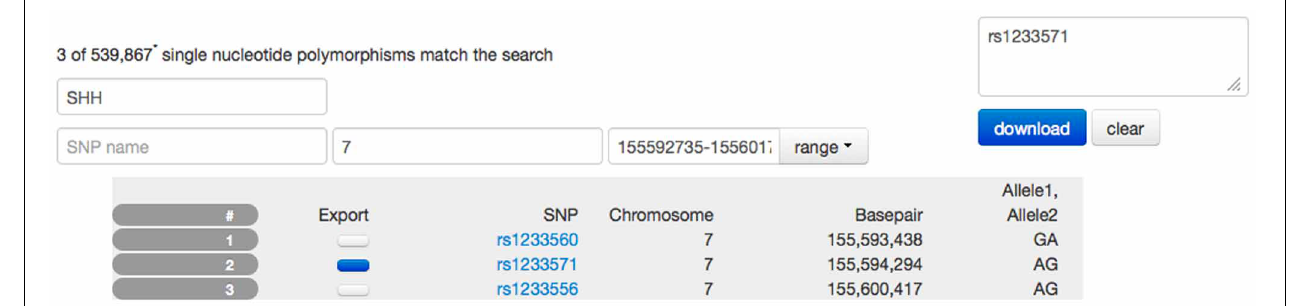
FIGURE 7 | Screen capture of the SNP browser application used to explore and extract genetic information available for the PING study. A search mask is used to specify a gene (SSH, sonic hedgehog). Utilizing a database with 80,000 entries, the SNP browser obtains the available chromosome number (7) and the basepair location (155,592,735–155,601,766) for this gene. The table is filled